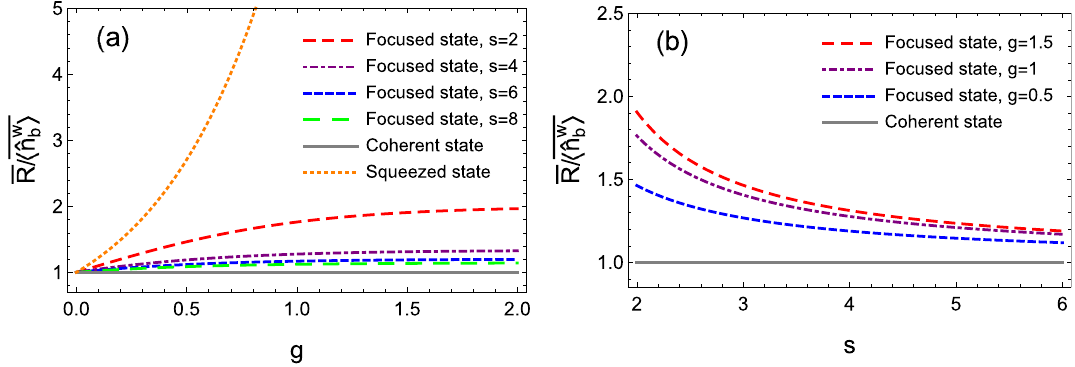
n w b � as a function of ( a ) the squeezing �ˆ